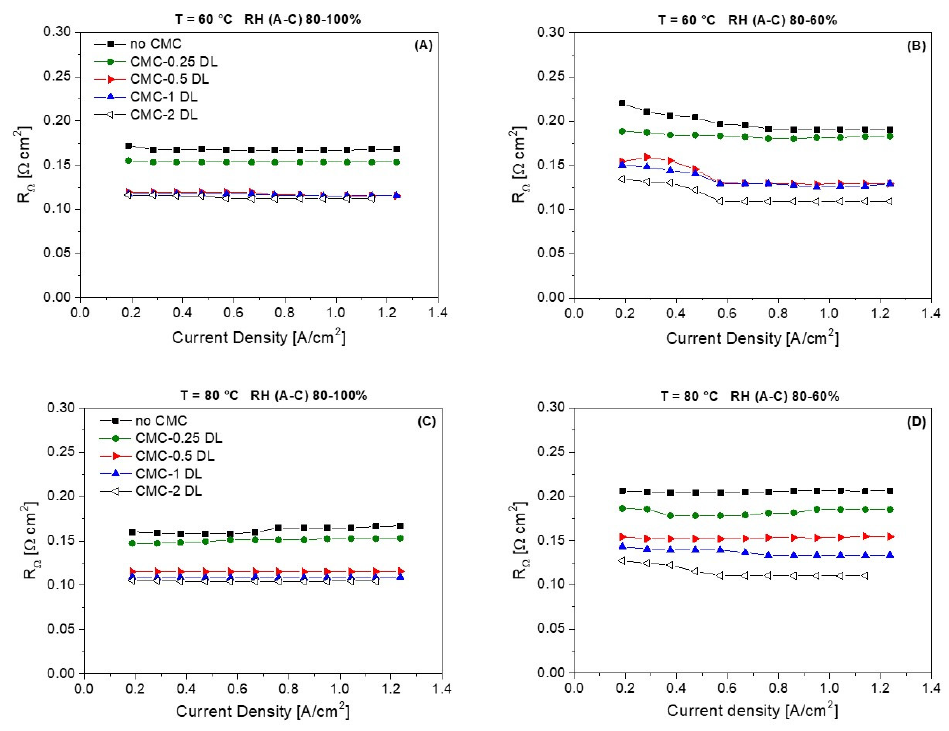
Figure 5. Ohmic resistance as a function of current density at ( A ) 60 °C and RH (A-C) 80–100%, ( B ) 60 °C and RH (A-C) 80–60%, ( C ) 80 °C and RH (A-C) 80–100%, ( D ) 80 °C and RH (A-C) 80–60%.